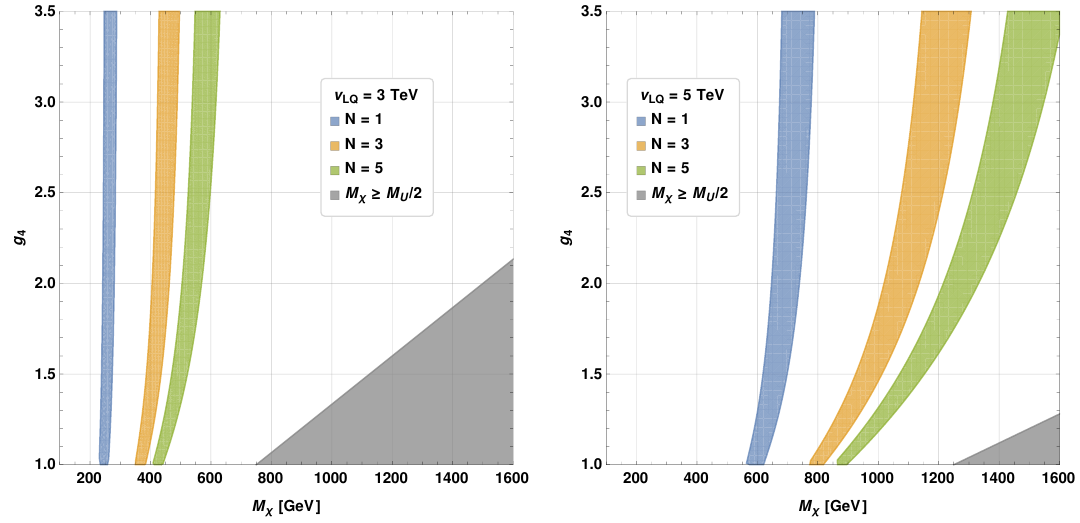
Figure 5 . Colored rays ful(cid:12)ll the (cid:10) 0 h 2 constraint within (cid:6) 15%. The gray region corresponds to an on-shell intermediate U 1 leptoquark (see text for